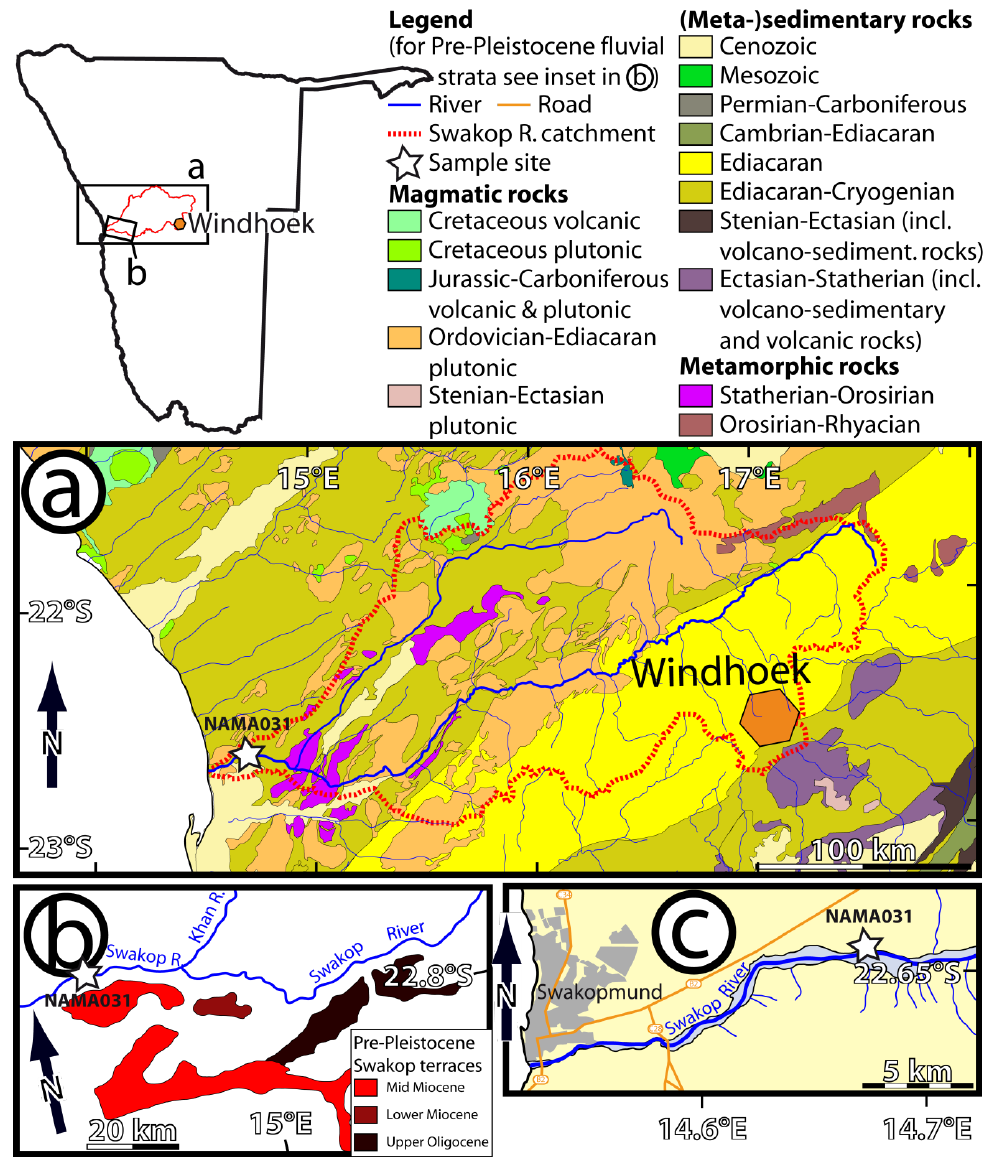
Figure 1. Geographic and geological overview of the study area and sampling site. ( a ) Geological map of the Swakop River catchment and its surrounding areas adapted from [44]. ( b ) Mapped Pre-Pleistocene terraces along the southern banks of the Swakop River [29] and references therein. ( c ) Sample locality of NAMA031 at the northern banks of the Swakop River east of Swakopmund.